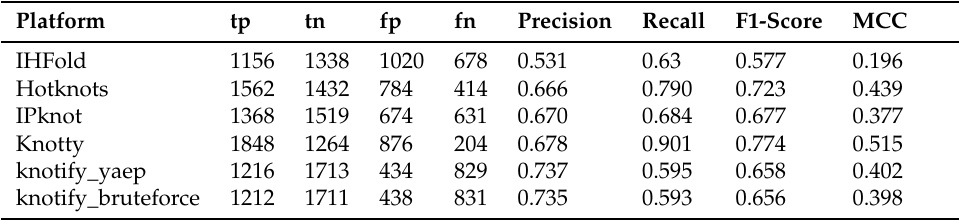
Table 9. Precision, recall, F1-score, and MCC per platform for sequences of length >=